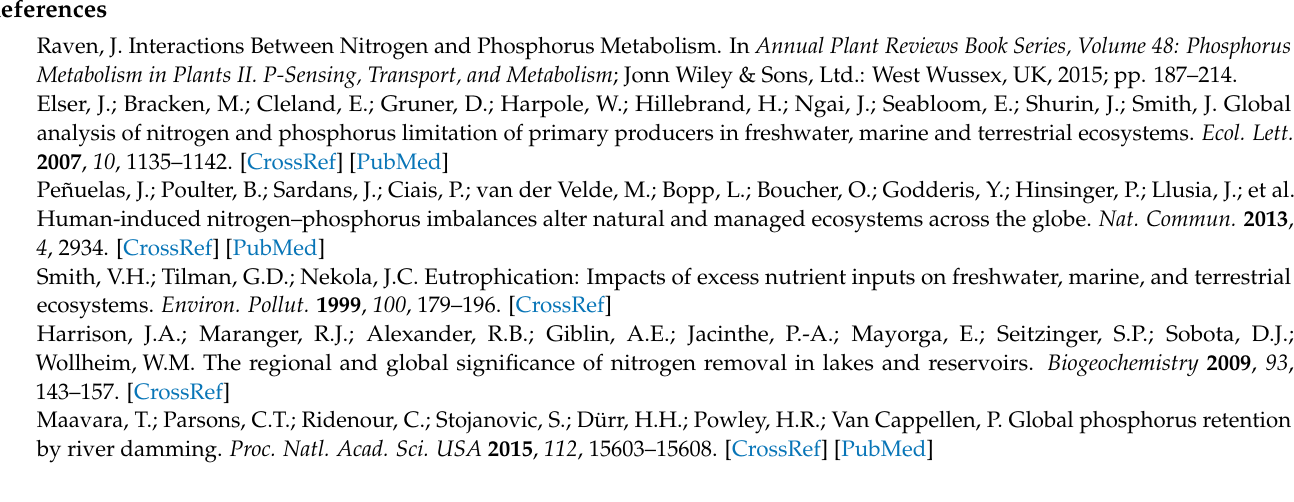
(i) sediment cut with 1-cm interval. Figure S3: Water temperature (a), pH (b), and DO (c) of water profiles in Hongfeng Lake in winter, Figure S4: Water temperature (a), pH (b), DO (c), ORP (d), Chlorophyll (e), and TDS (f) of water profiles in Hongfeng Lake in summer, Figure S5: Water tem- perature of river outlets(a) and still water zone (b) of water profiles in Hongfeng Lake in summer, Figure S6: P and Fe concentration and proportion of surface sediment of Hongfeng Lake, Figure S7: Correlation analysis among inflow, lake water velocity and total bed shear, Figure S8: Linear rela- tionship between water vertical velocity and cumulative daily radiation, Figure S9: The simulated velocity magnitude of surface water, the vertical velocity, bottom water, and total bed shear in sample sites in January. The legend from top to bottom showed HF1~ 6 in turn, Figure S10: The simulated velocity magnitude of surface water, the vertical velocity, bottom water, and total bed shear in sample sites in July. The legend from top to bottom showed HF1~ 6 in turn, Figure S11. The water velocity (a) Day 14:00 29/07/ 2013; (b) Light 20:00 30/07/2013; (c) Temperature in the profiles of Hongfeng Lake; (d) The black line in Hongfeng Lake is the section. Table S1: Characteristics of the 24 water sampling sites and 6 sediment sampling sites, Table S2: Hydrodynamic and temperature modules parameter of Hongfeng Lake in EFDC, Table S3: Sample points information for verification and input data, Table S4: Verification of temperature module of Hongfeng Lake by EFDC and measured data, Table S5: Concentration in sediment, deposit rate, enrichment degree in sediment, release flux of N and P at the sediment-water interface in Hongfeng Lake, Table S6: Porosity ϕ , diffusion coefficient Ds, diffusion flux of NH 4+ , NO 3 − , labile P surface sediment concentration, deposited fluxes of N and P, and the contribution rate of diffusion flux on the overlying water and sediment in Hongfeng Lake, Table S7: Velocity and total bed shear at HF1~HF6, Hongfeng Lake, in winter (W) and summer (S) (mean ± standard